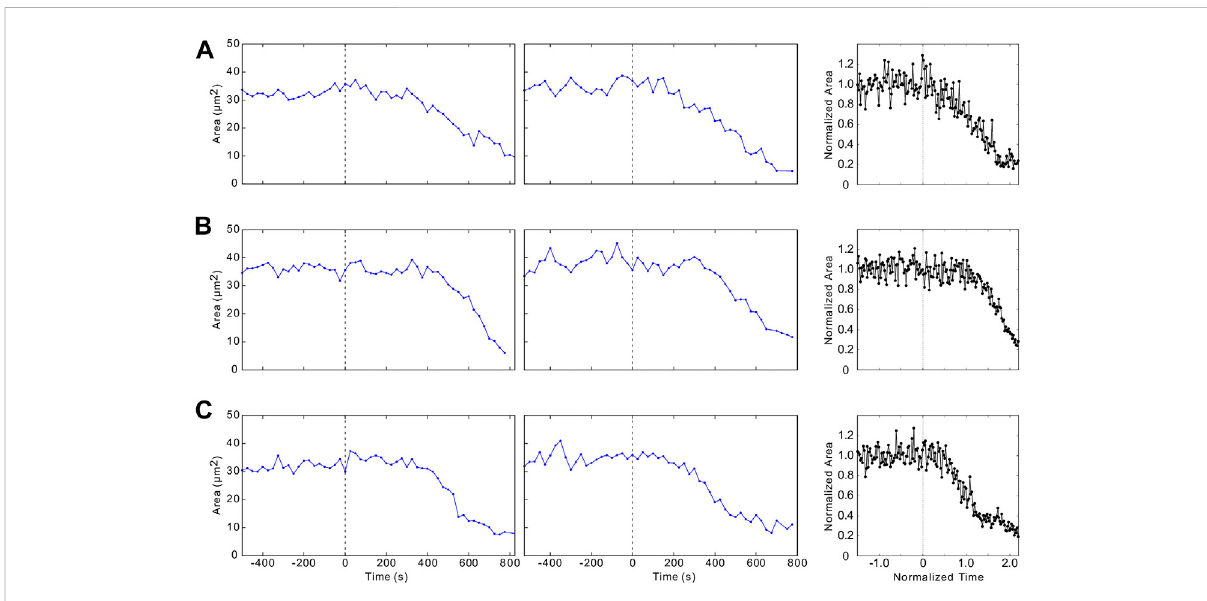
FIGURE 9 Constriction histories of individual cells. (A – C) depict examples of time evolution of individual cells for the same embryos as the ones analyzed in Figures 1 – 3. Embryo 2 ( fi rst column), Embryo 1 (second column), and simulated trajectories (third column).